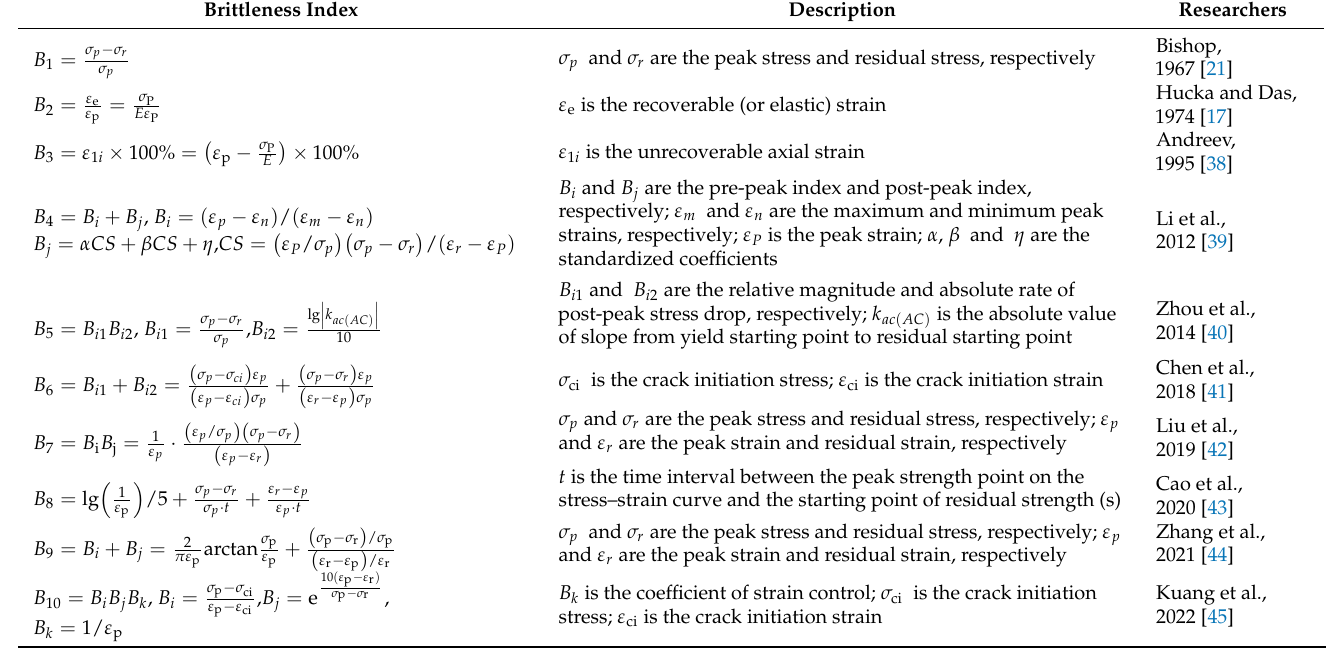
Table 1. Brittleness indexes based on stress–strain curve and characteristic